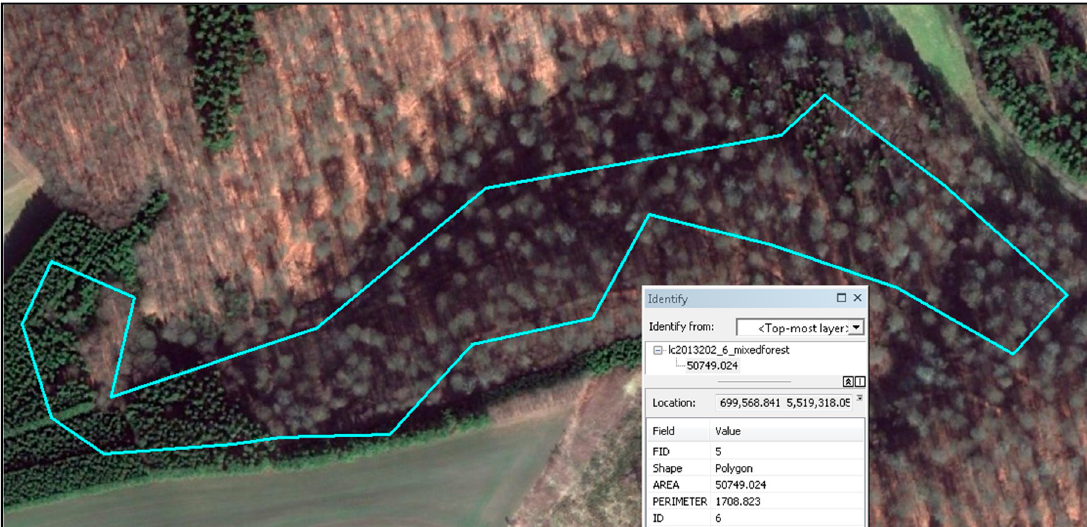
Figure 1. A 0.7 by 0.3 km area with a seemingly faulty reference polygon (center coordinates 49°47’37”N, 5°46’28”E), which was labelled as mixed forest but that appears to be mostly covered by deciduous trees in the backdrop, which is a leaf-off image from Google